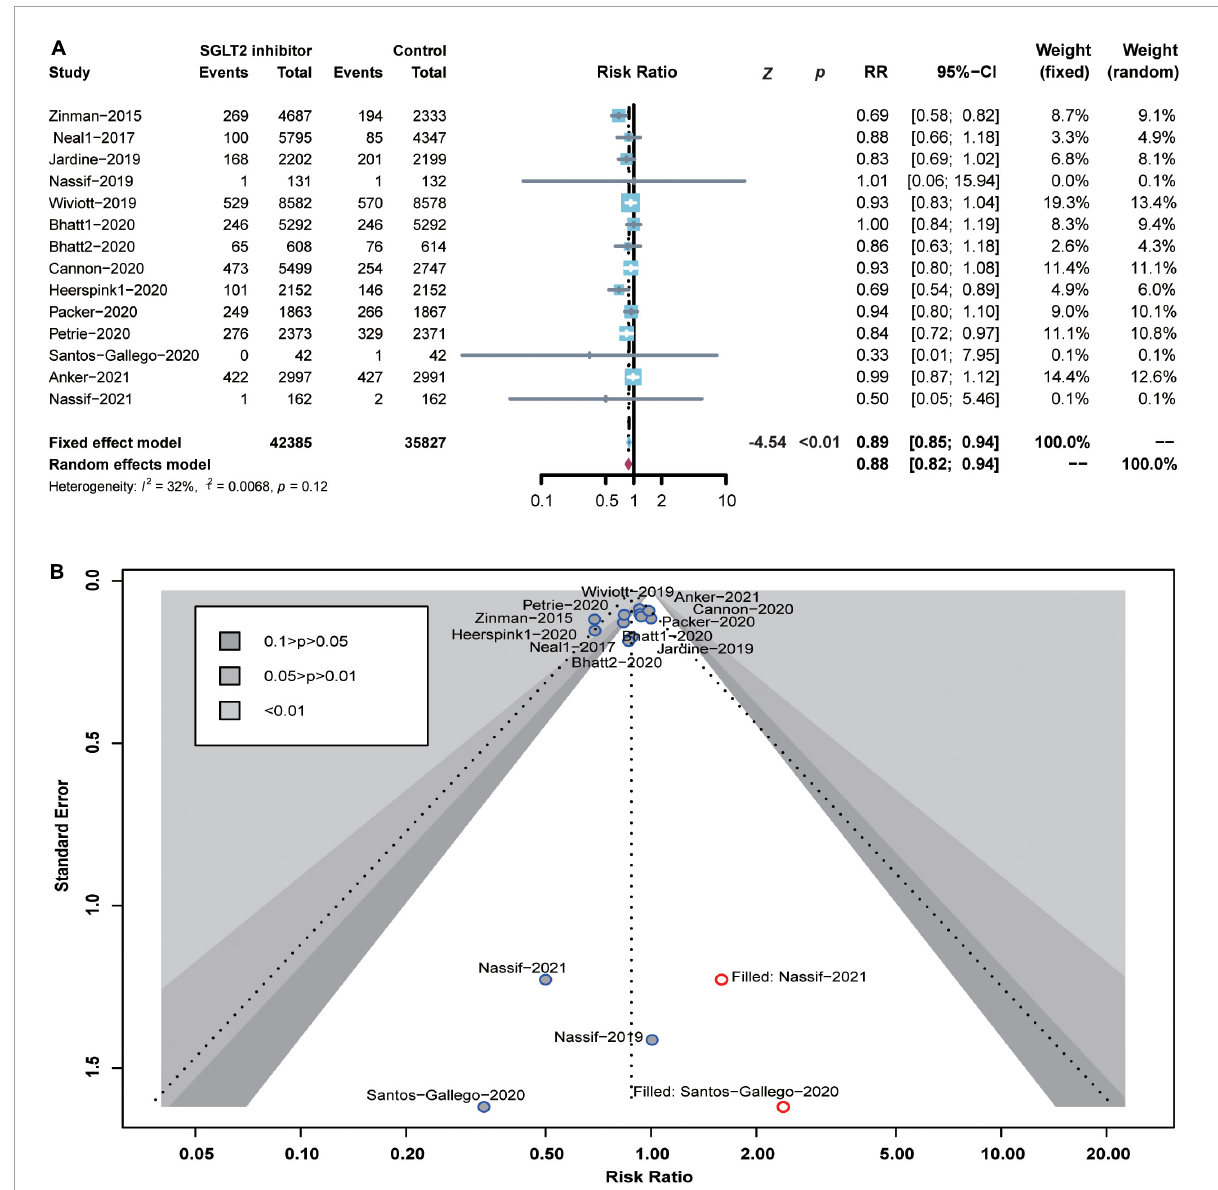
FIGURE3 Forest plot of all-cause death and the detection of publication bias. (A) Forest plot of all-cause death; (B) funnel chart of trimming and filling.